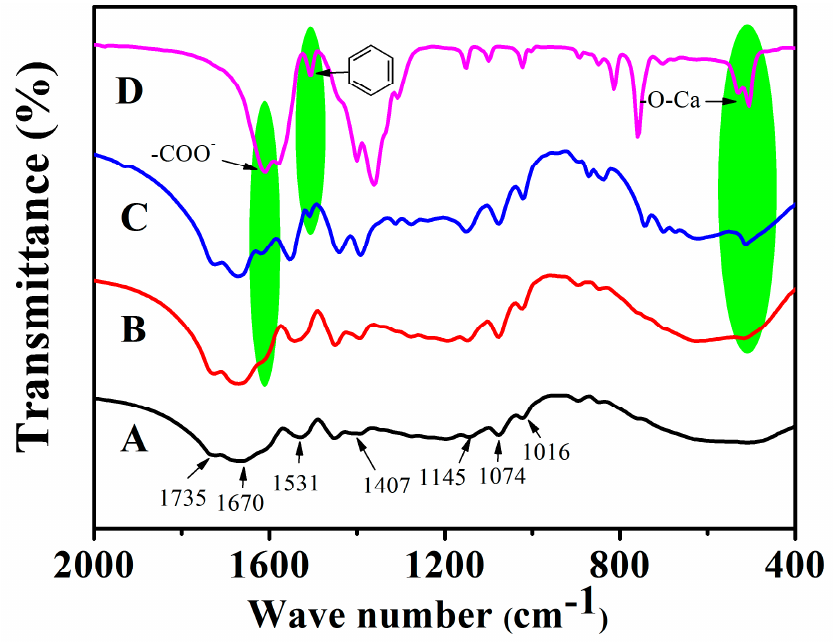
The FT-IR spectra of ( A ) P 0 C 50 W 15 , ( B ) P 0.75 C 50 W 15 , and ( C ) P 3 C 50 W 15 , ( D ) as-synthesized Ca-BDC. TG analysis of P 0 C 50 W 15 containing no Ca-BDC, P 3 C 50 W 15 containing 3 g Ca-BDC, and